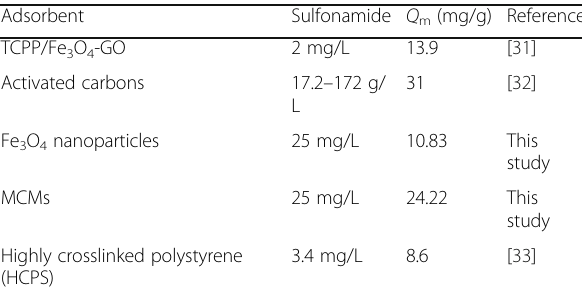
Table 5 Adsorption capacity comparison of MCMs with other absorbents reported for sulfonamide